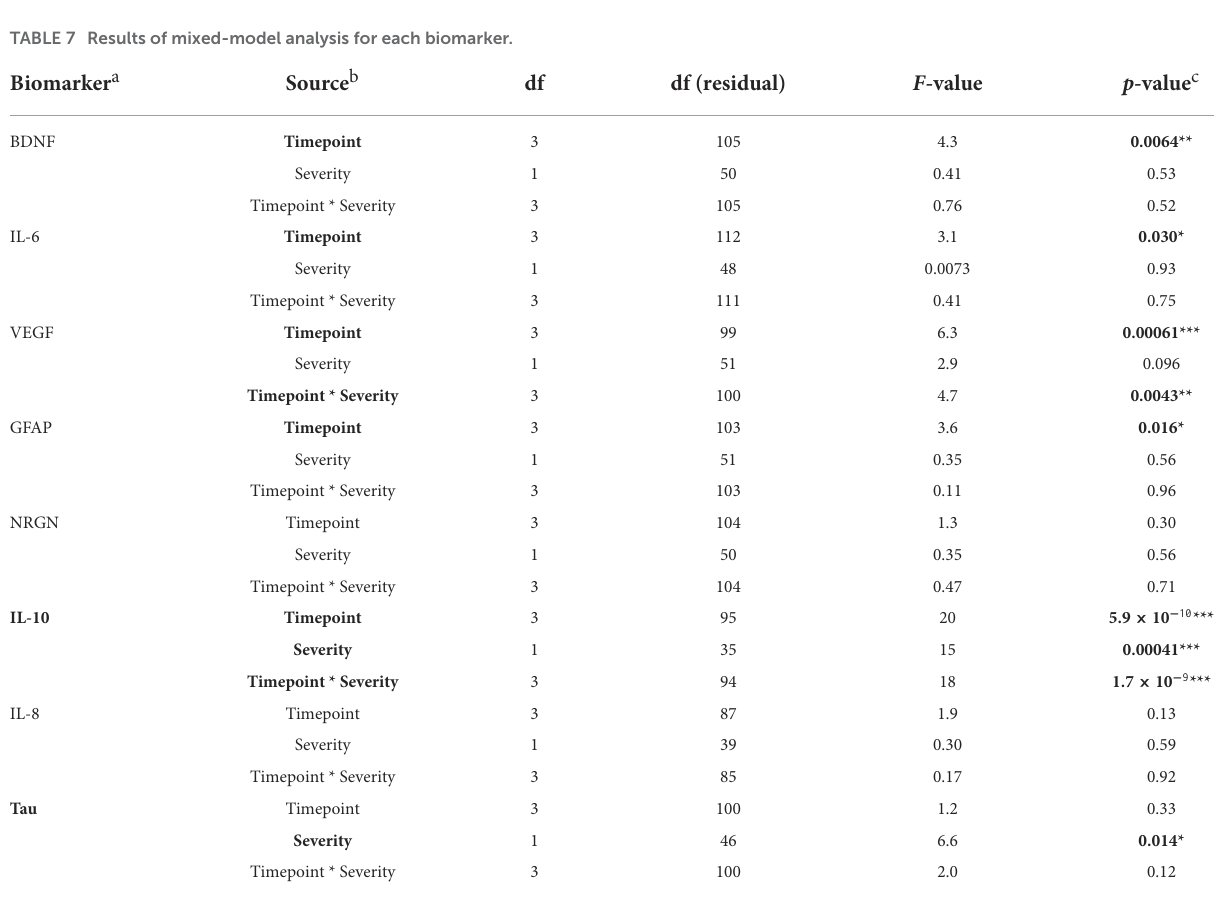
TABLE 7 Results of mixed-model analysis for each